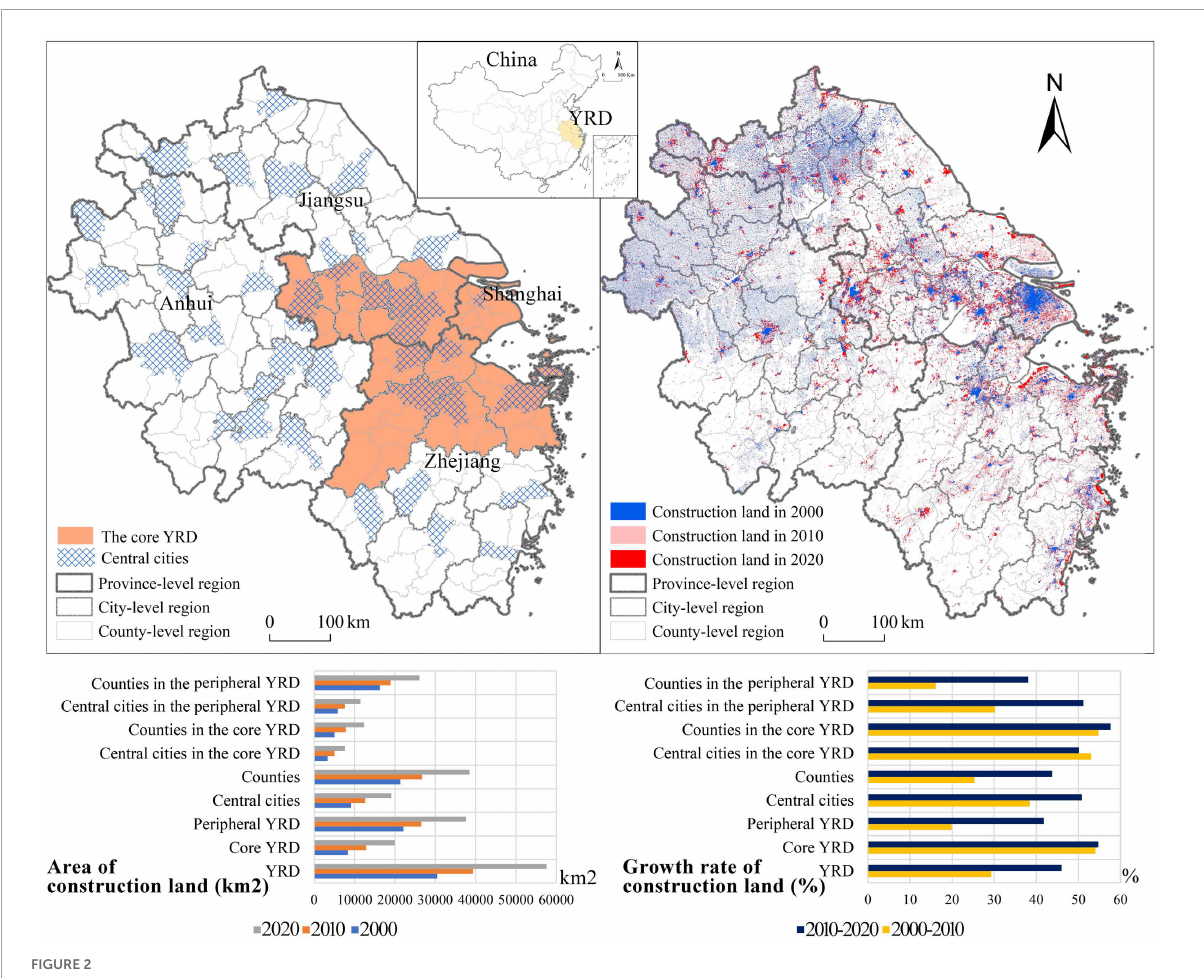
FIGURE2 Location and construction land expansion of the study